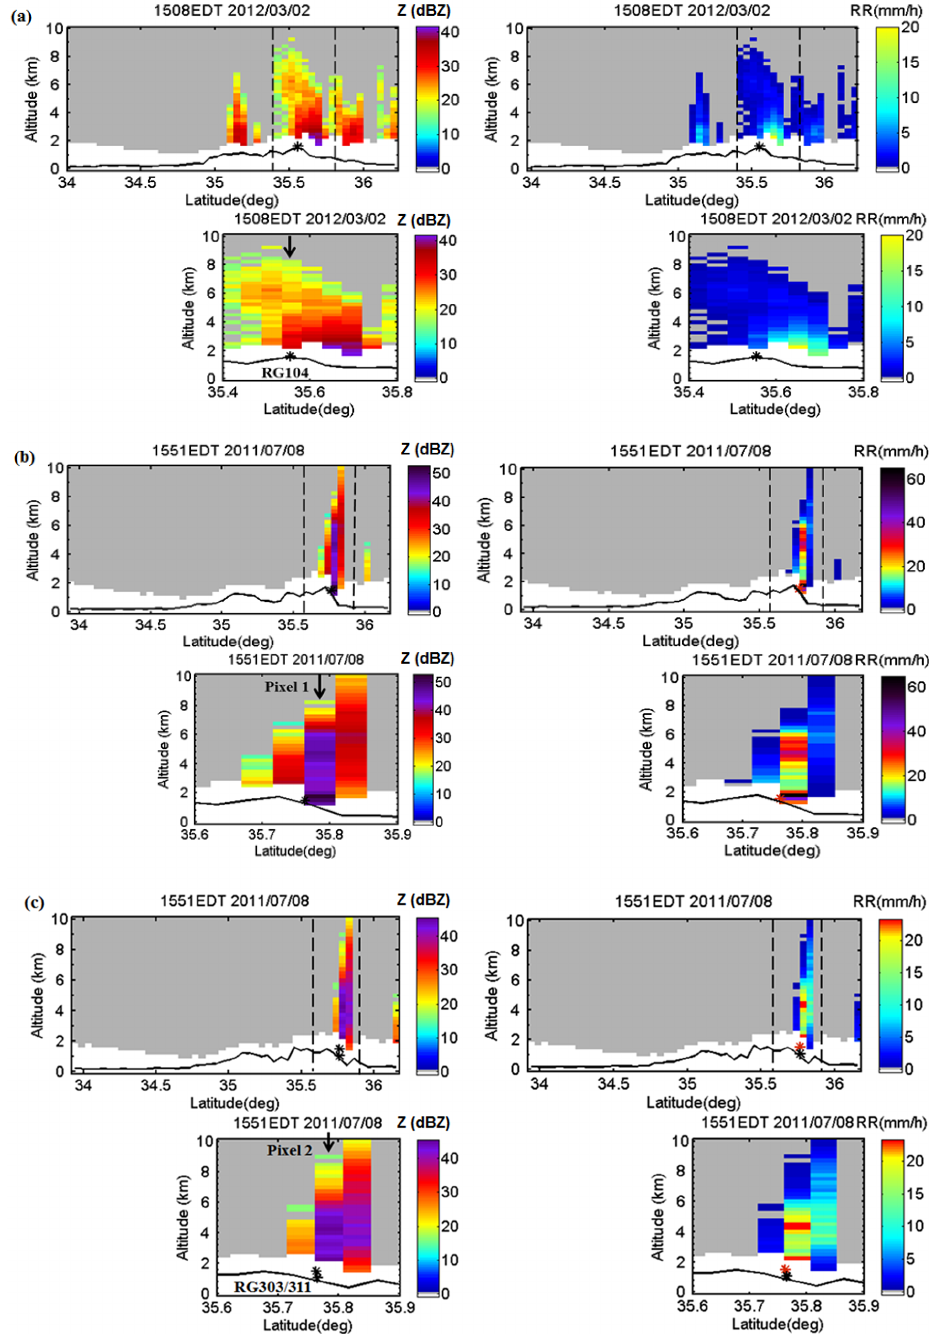
Figure 10. Cross section of reflectivity ( Z ) and rain rate estimates (RR) from TRMM 2A25 for three underestimation cases: (a) 15:08EDT on 2 March 2012; and for two different cross sections at 15:51EDT on 8 July 2011 (b, c) . The top row shows the overpass cross section. The bottom row shows the cross section between the two dashed vertical lines in the top rows. Asterisks denote the position of the raingauges as marked, and the color in the right panel is consistent with the measured rain rate. The black arrow identifies the PR profile used to make the error determination. Ground-clutter flags are shown in white. The black continuous line represents the